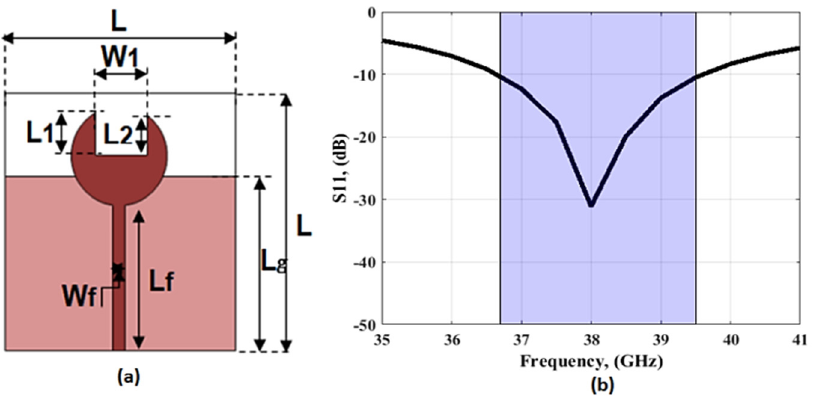
Figure 4. The suggested 38 GHz antenna ( a ) 2D configuration (L = 12 mm, L1 = 2.45 mm, L2 = 2.35 mm, W1 = 2.2 mm, Wf = 0.4 mm, Lf = 7 mm, and Lg = 7.7 mm) ( b ) The S 11 result.